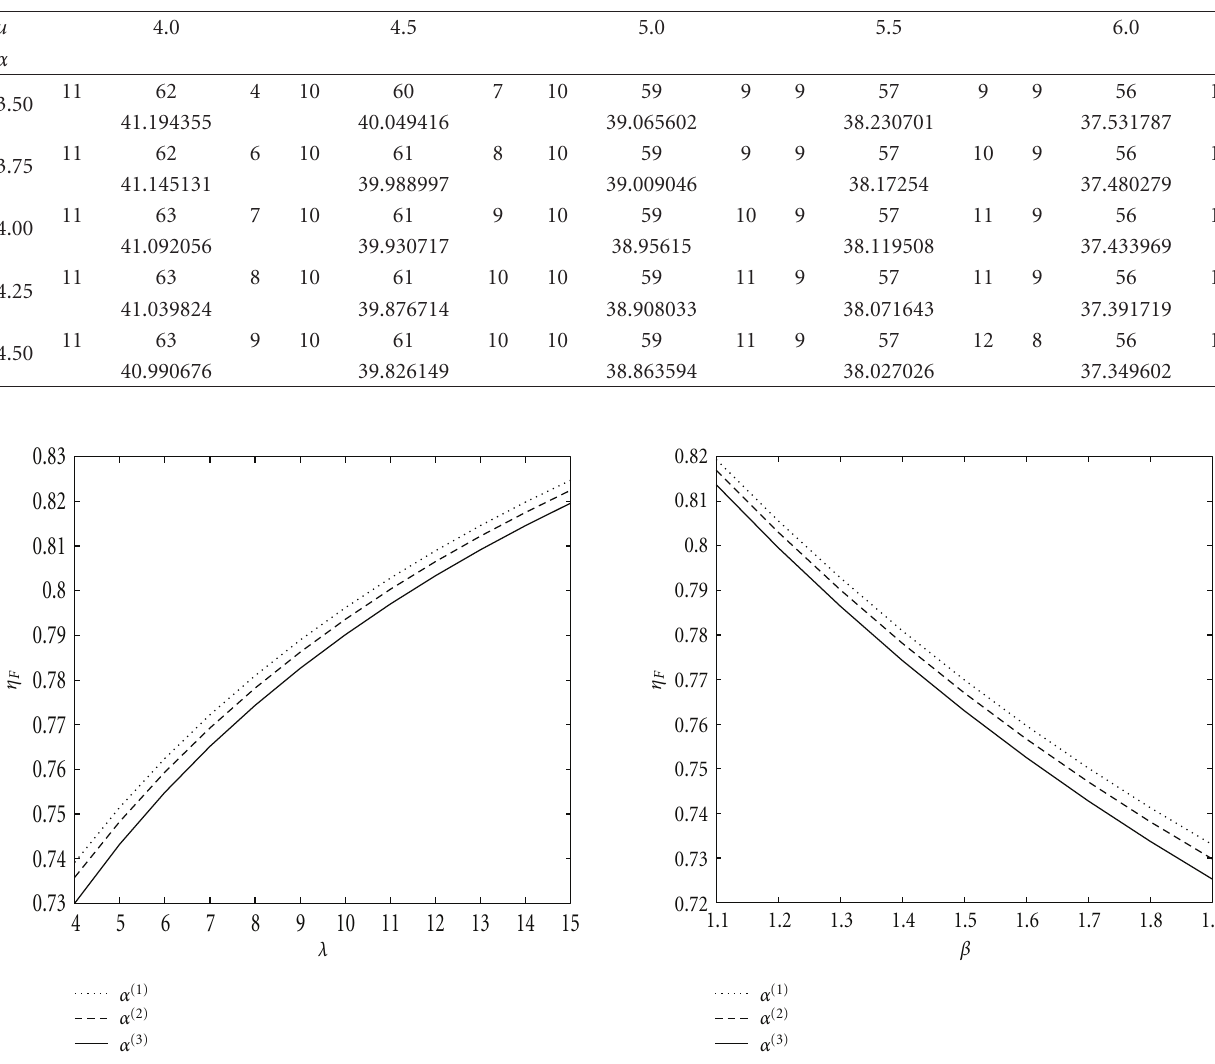
Table 6: Influence of the postponed demand rate and replenishment rate on the optimal values ( λ = 14, γ = 1 . 4, β = 1 . 3, p = 0 . 85).